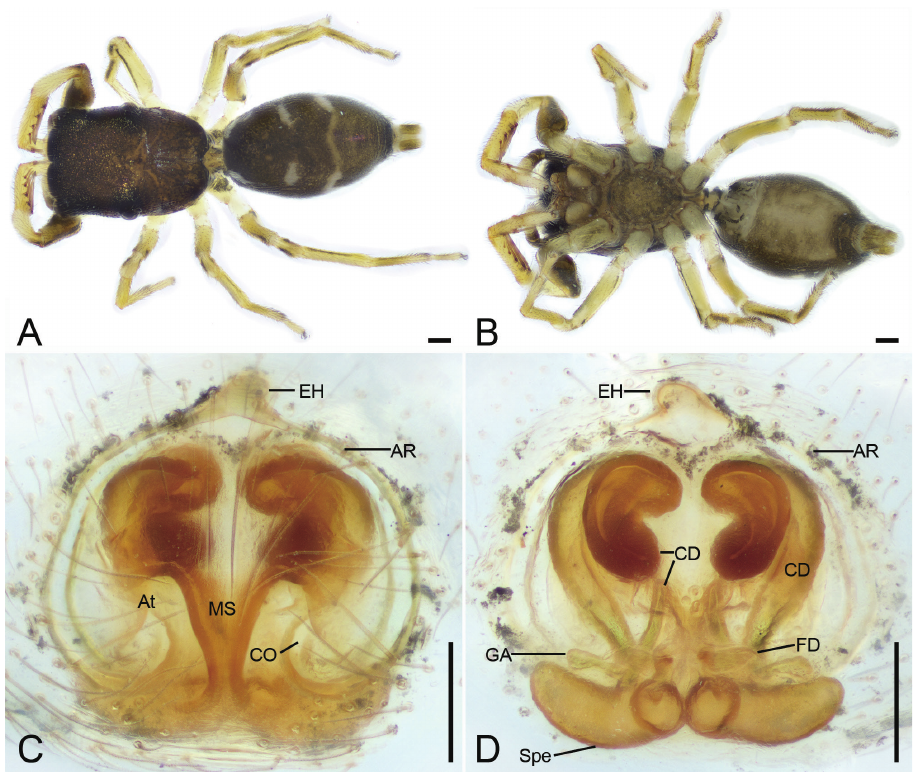
Figure 12. Synagelides triangulatus sp. nov., holotype female A habitus, dorsal view B same, ventral view C epigyne, ventral view D same, dorsal view. Abbreviations: AR – atrial rim, At – atrium, CD – copula- tory duct, CO – copulatory opening, EH – epigynal hood, FD – fertilization duct, GA – glandular ap- pendages, MS – median septum, Spe – spermatheca. Scale bars: 0.2 mm ( A, B ); 0.05 mm ( C, D 0.28); II 1.88 (0.6, 0.28, 0.3, 0.4, 0.3); III 2.34 (0.67, 0.37, 0.46, 0.57, 0.27); IV 3.06 (0.79, 0.39, 0.81, 0.73, 0.34). Femur width: I 0.29; II 0.17; III 0.18; IV 0.25. Leg spination (Fig. 12A, B): I ti pv 2-2-1, rv 2-2-0; Met pv 1-0-1, rv 1-0-1. Pedicel 0.18. Abdomen 1.57 long, 0.96 wide. Coloration (Fig. 12A, B). Carapace dark reddish brown, anterior part darker than posterior, posteriorly with radial grooves, 14–16 rows of short black setae. Endites yellow-brown, mottled. Labium yellow-brown, anteriorly with two rows of strong se- tae. Sternum, yellow-brown, mottled, with dark brown, mottled stripes around mar- gin. Legs: trochanters yellow, with dark brown stripe; femur I dark yellow-brown, femora II–IV yellow, with distinct prolateral and retrolateral dark brown stripes; patel- lae, tibiae, and metatarsi yellow, with dark brown lateral stripes; tarsi yellow. Abdomen dark yellow-brown, mottled, with three clear white spots consisting of abundant white setae antero-laterally and three chevron-shaped stripes (the medial one clear, others indistinct) medially; venter with many irregular yellow-brown spots postero-medially. Spinnerets yellow-brown, mottled.